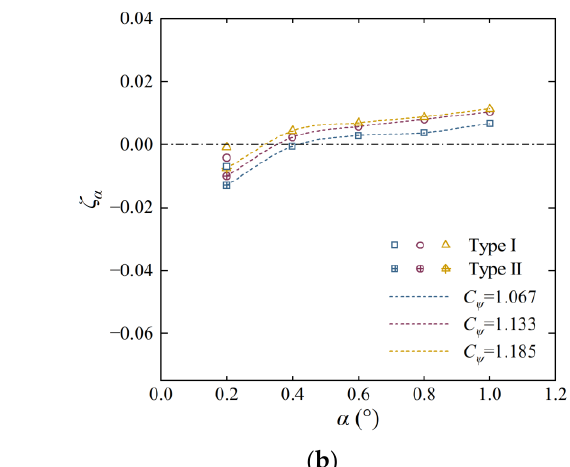
Figure 21. Damping ratios of GV torsional self-excited vibration: ( a ) GV-O ; ( b ) GV-M .